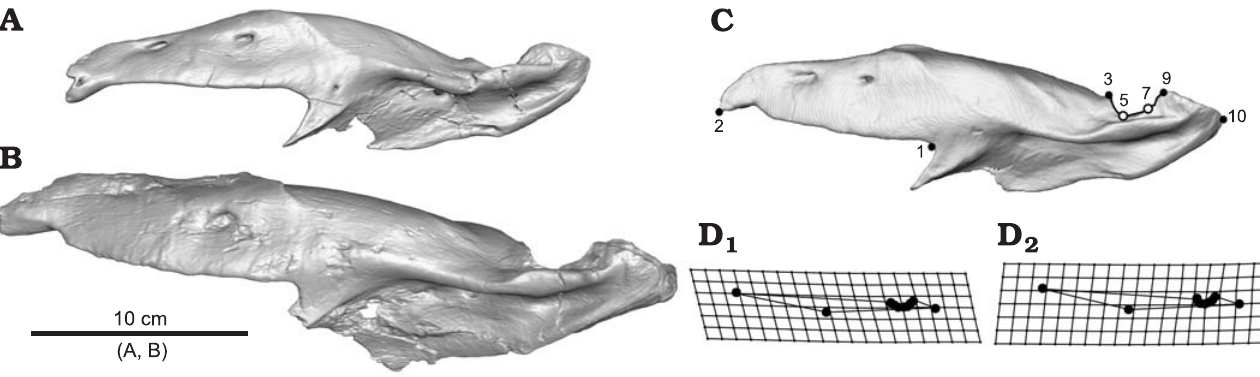
Fig. 10. Representative surangulars (rendered CT images) of Majungasaurus crenatissimus (Depéret, 1896) Lavocat, 1955 from the Maastrichtian (Upper Cretaceous) Maevarano Formation, northwestern Madagascar in left lateral view. A . FMNH PR 3369. B . FMNH PR 2100. C . Illustration of land- mark positions used for surangulars, UA 9944 (not to scale). Black circles, landmarks; white circles interconnected with solid lines, semilandmarks. D . Ontogenetic shape change visualized by deformation grids relative to average; outline of smallest (D 1 ) and largest (D 2 ) specimens